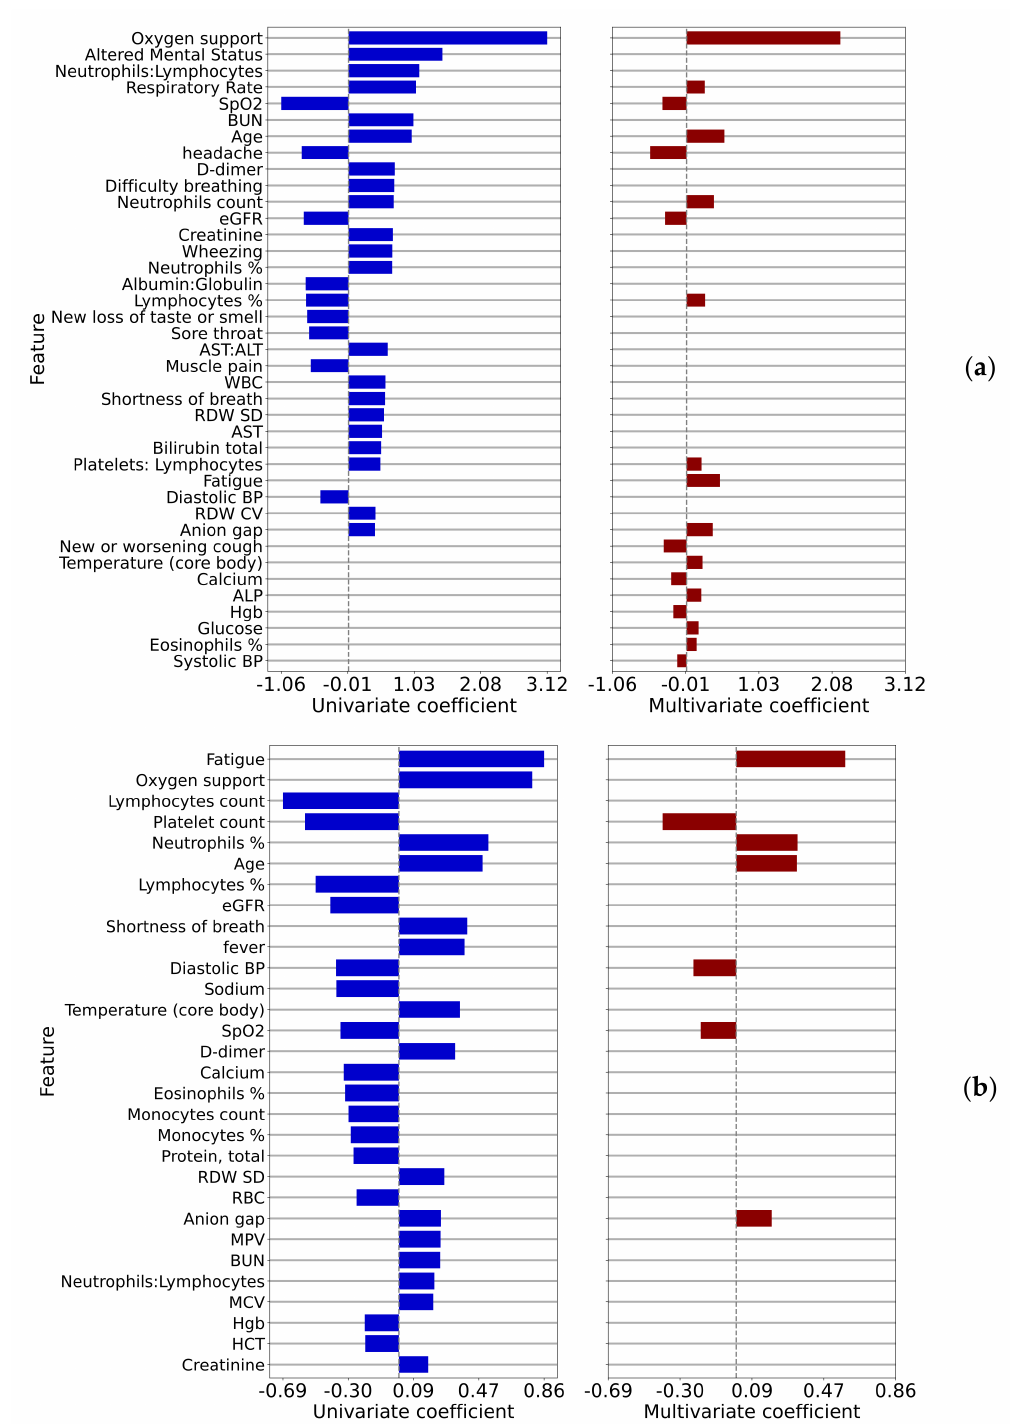
Figure 3. Univariate and multivariate logistic regression coefficients for comparisons 1 ( a ) ED admission and 2 ( b ) ED